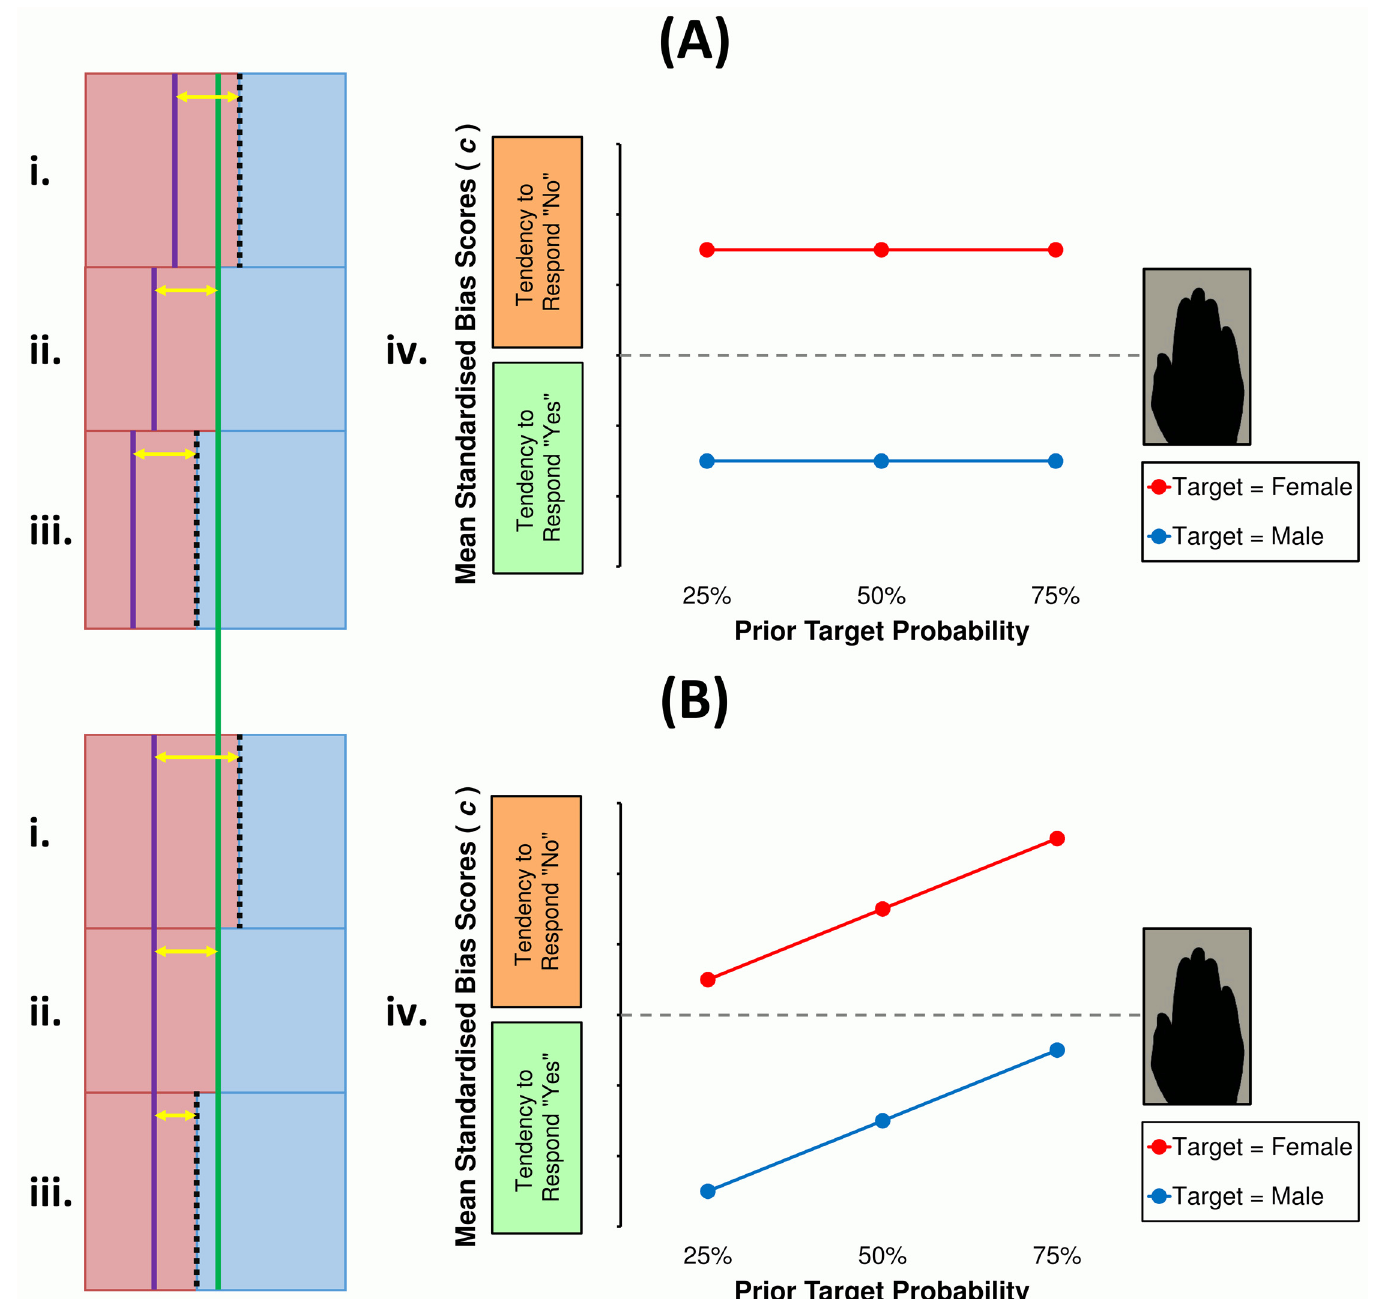
Fig 2. Alternative models and predicted outcomes of male-biased criteria setting. As PTP changes, MB may arise via opposing mechanisms. The size (not to scale) of each blue relative to pink rectangle represents PTP ( i : 25%; ii : 50%; iii : 75%). ( A ) If, under ambiguous conditions, observers are nonetheless sensitive to PTP change, they should attenuate their liberal male criterion ( i-iii : purple lines) relative to the optimal criterion ( i, iii : dotted lines; ii : green line) when targets are ( i ) scarce, ( ii ) equal, or ( iii ) common. If so, in the present study ( iv ) there should be no difference between mean criteria as measured under different PTP conditions. ( B ) Alternatively, if observers neglect change in optimality, they may set male-favouring criteria ( i-iii : purple line) relative to a fixed population estimate of PTP (green line). This would effectively inflate criteria measures when male targets are scarce ( i : yellow arrow) and diminish the same when targets are frequent ( iii : yellow arrow), which in the present study ( iv ) would manifest as a linear association between bias measures and PTP.